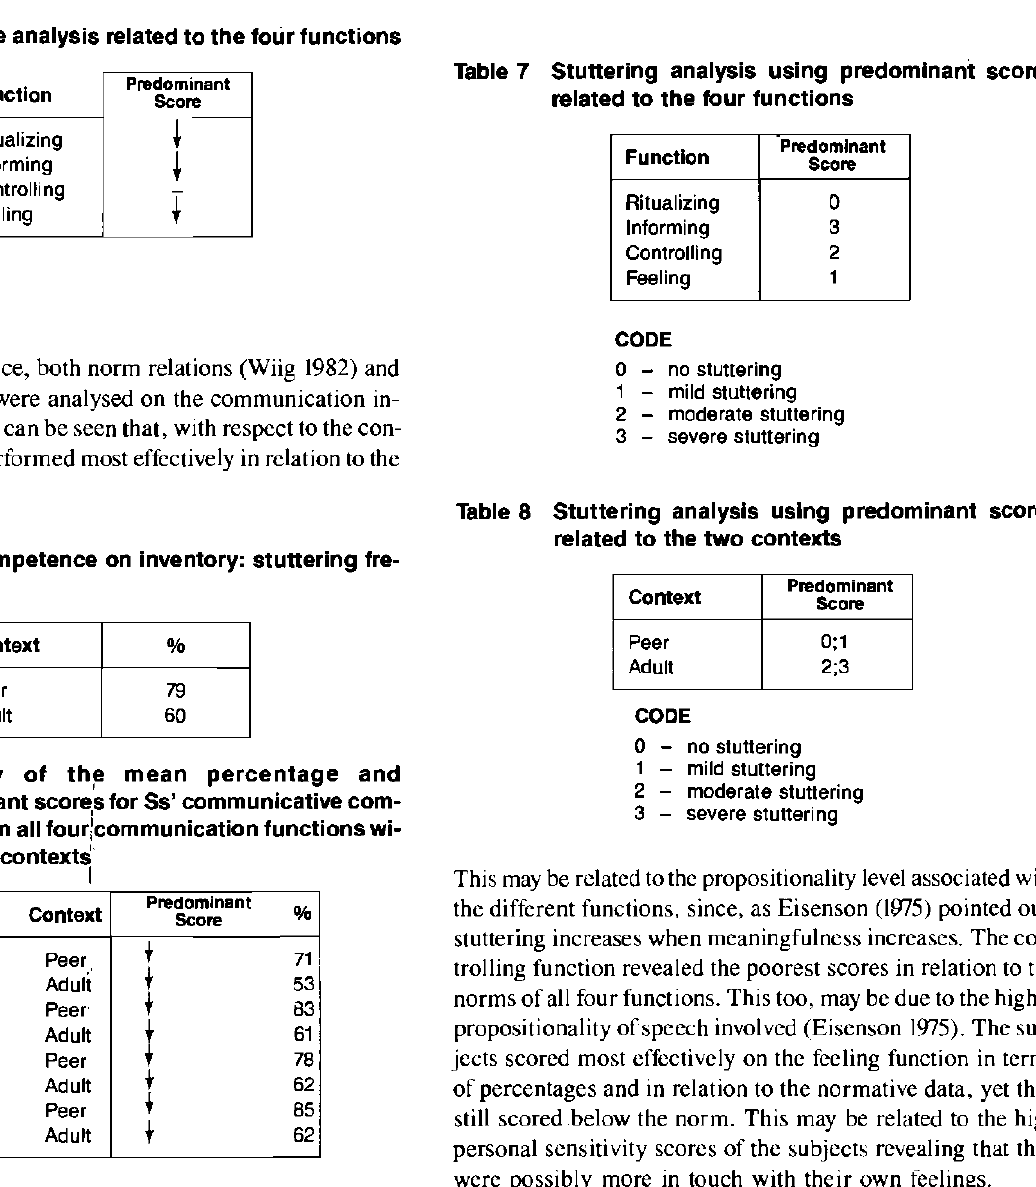
Table 7 Stuttering analysis using predominant scores